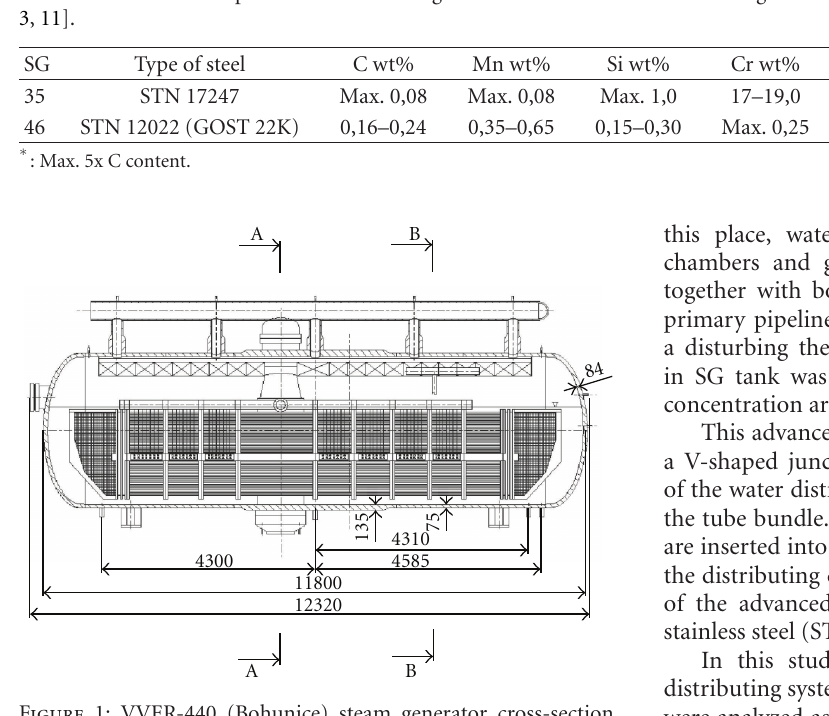
Figure 1: VVER-440 (Bohunice) steam generator cross-section. Bohunice innovation [14–16].